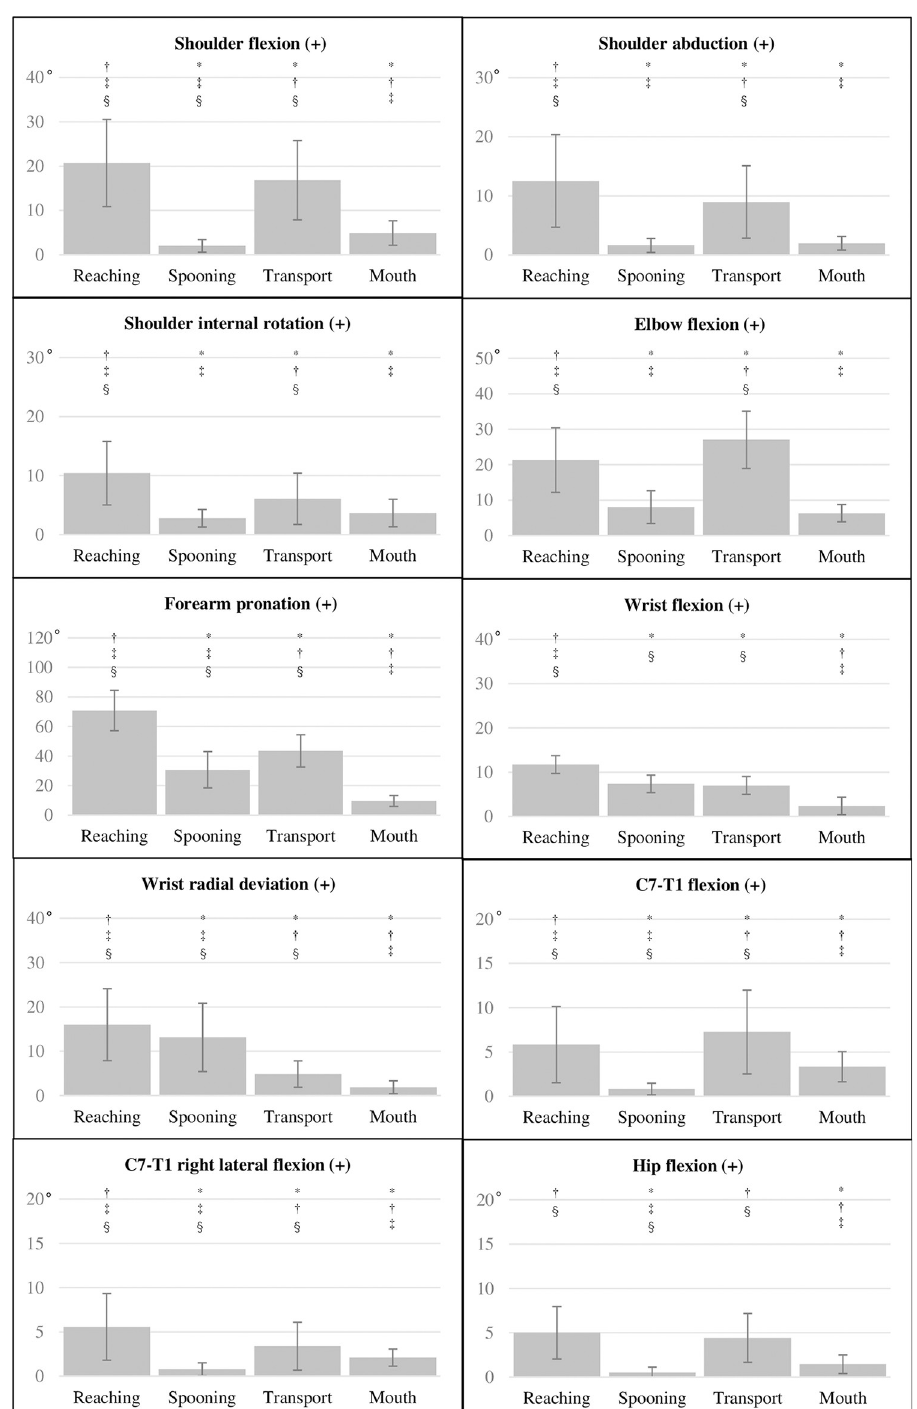
Fig 2. Ranges of motion in each of the four eating phases with Bonferroni correction. Eating phases are shown on the horizontal axis. � , significant difference (p < 0.008) compared to the reaching phase; † , significant difference (p < 0.008) compared to the spooning phase; ‡ , significant difference (p < 0.008) compared to the transport phase; § , significant difference (p < 0.008) compared to the mouth phase.